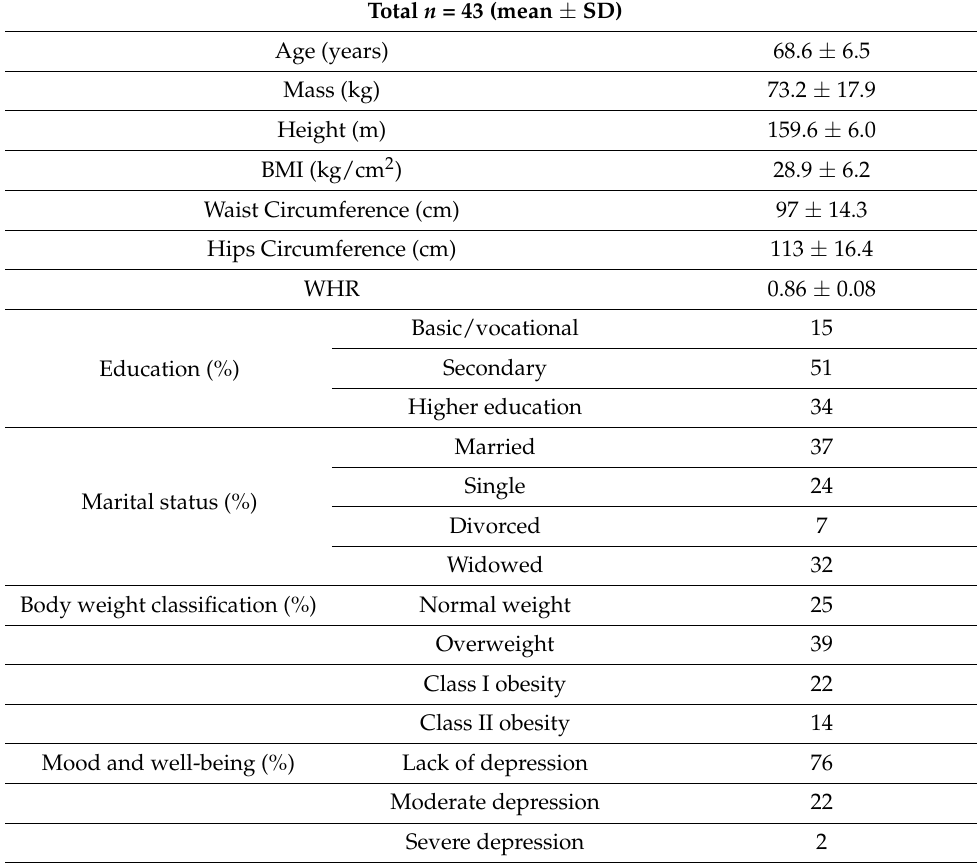
Table 1. Participants’ baseline characteristic, n = 43.